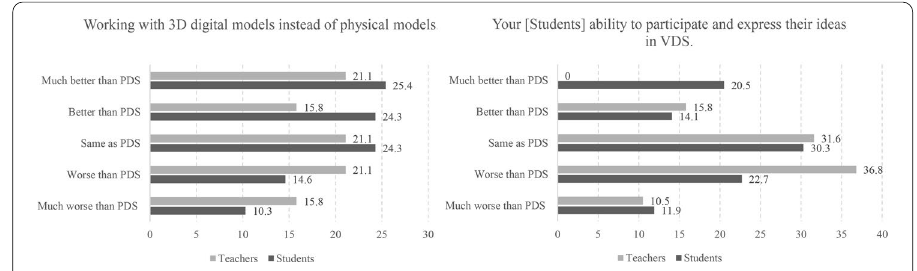
Fig. 4 Left, the effectiveness of the 3D working model in VDS compared to PDS; right, students’ ability to express their ideas in VDS compared to PDS